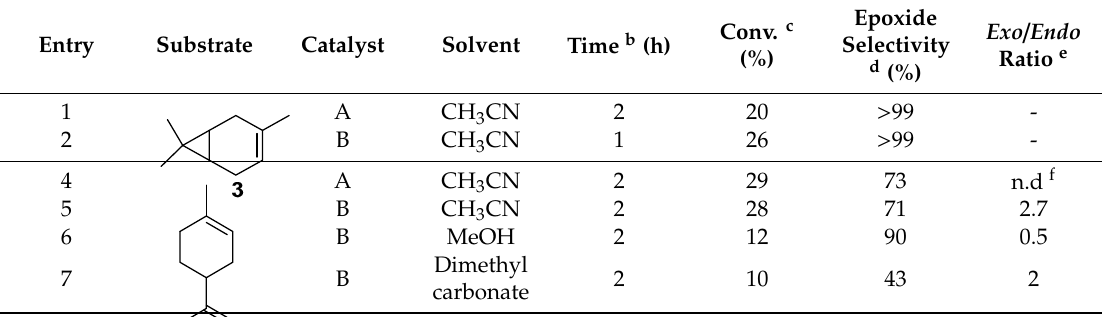
Table 11. Oxidation of 3-carene and limonene using mesoporous niobium-silicates a (adapted from reference [45]).